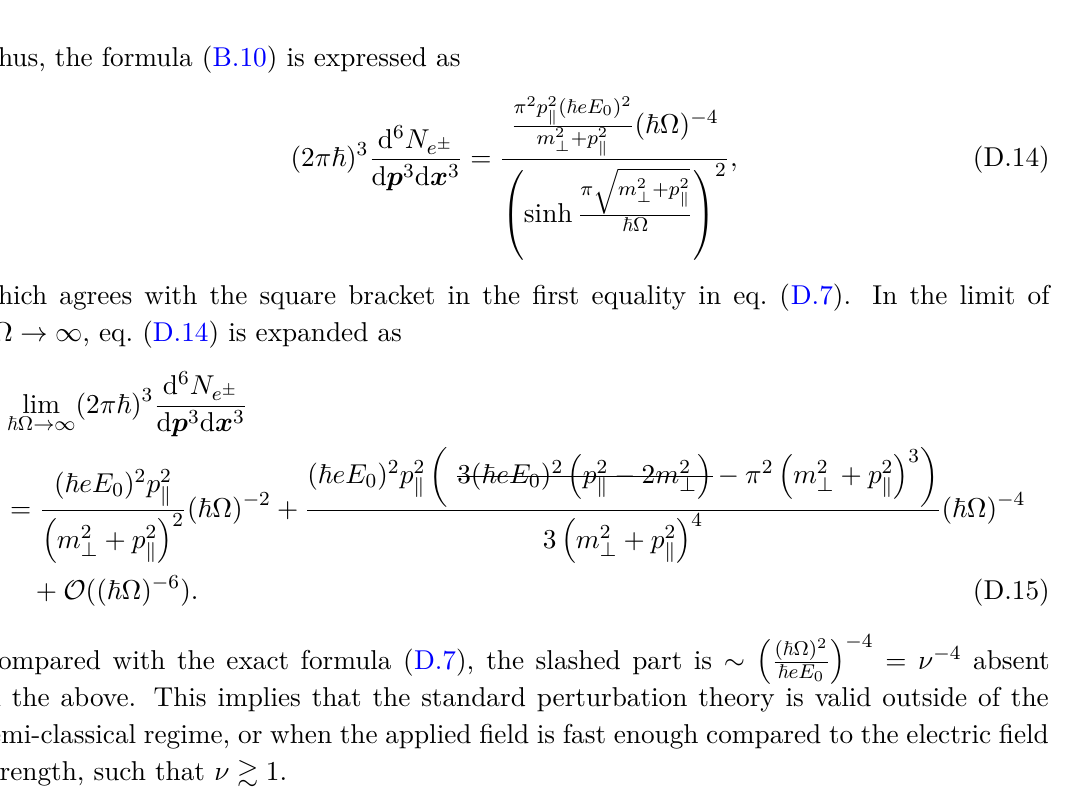
Figure 8 . (color online) Stokes graphs for a constant strong electric field superimposed by a weak cosine perturbation (3.56). The parameters are common to the three panels ~ eE s /m 2 = 0 . 25 , E w /E s = 0 . 01 , | p ⊥ | /m = 0 , and p /m = 0 . 20 , except for the frequency ~ Ω /m = 0 . 5 , 1 , 2 from k the left to right, respectively. The red points, the blue lines, and the green lines are representing turning points, Stokes lines, and branch cuts,